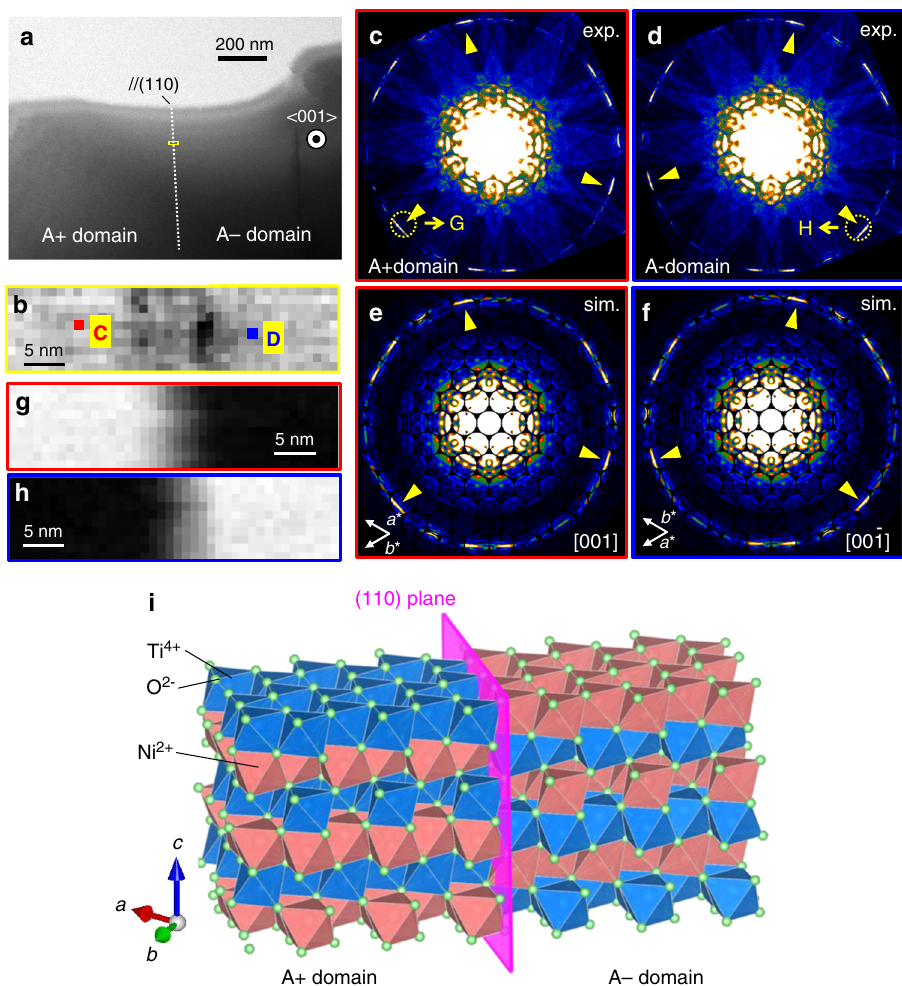
R-- Fig. 3 STEM-CBED maps and CBED patterns in the 3 ferroaxial phase of NiTiO 3 . a Bright- fi eld scanning transmission electron microscope (BF-STEM) image obtained with the 001 incidence, where a domain boundary // (110) is indicated by a white dotted line. Crystal orientations determined from the STEM-CBED patterns of ( c ) and ( d ) are schematically shown. b Magni fi ed view of a yellow-box area in ( a ). c , d (exp.) Convergent-beam electron diffraction (CBED) patterns obtained with the 001 incidence at positions C and D shown in ( b ) are displayed in ( c ) and ( d ), respectively. These measurements were carried out at room temperature, that is, in the R (cid:1) 3 ferroaxial phase. e , f (sim.) Simulated CBED patterns of the R (cid:1) 3 phase of NiTiO 3 with the ( e ) [001] and ( f ) [00 (cid:1) 1] incidence. The specimen thickness used for the simulations was 35 nm. The measured CBED patterns displayed in ( c ) and ( d ) well match up with the simulated ( e ) and ( f ), respectively [see higher-order Laue zone (HOLZ) re fl ections indicated by yellow arrowheads]. g , h STEM- CBED maps obtained from the intensities of the HOLZ re fl ections at G and H [yellow-dotted circles in ( e ) and ( f ), respectively]. i Orientations of A + and A − domains and the domain boundary determined from the STEM-CBED measurements. Scale bar: 200 nm for ( a ) and 5 nm for panels ( b ), ( g ), and ( h